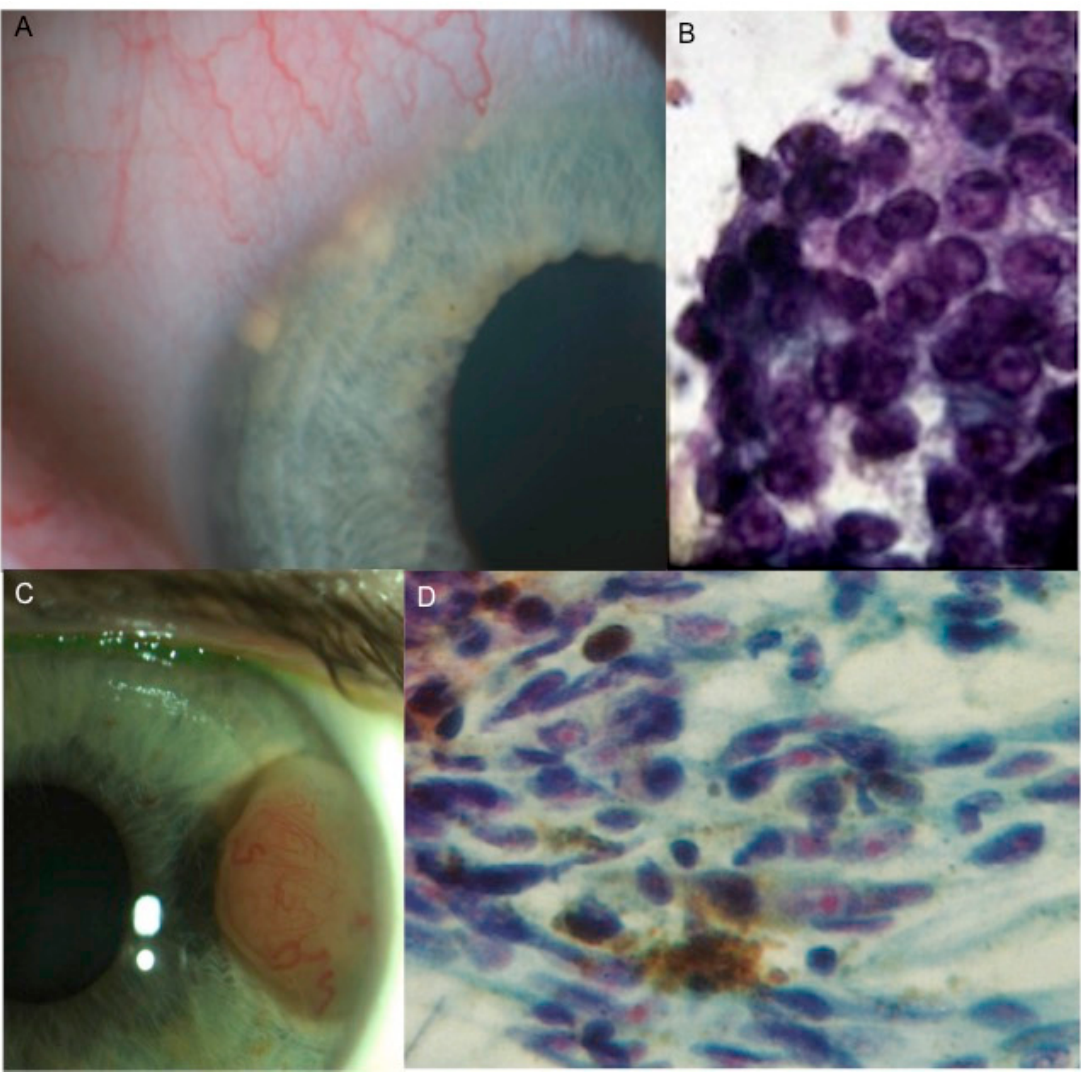
Figure 6. ( A , B ) A case of iris metastasis characterized by ( A ) multiple anterior chamber angle nodules in a patient previously treated by surgery and systemic chemotherapy because of a breast carcinoma (ductal type). ( B ) Intraocular fine needle aspiration biopsy of the same case confirming the diagnosis of iris metastasis from breast carcinoma. ( C , D ) A case of ( C ) iris partially amelanotic melanoma confirmed at cytology by ( D ) fine needle aspiration biopsy.